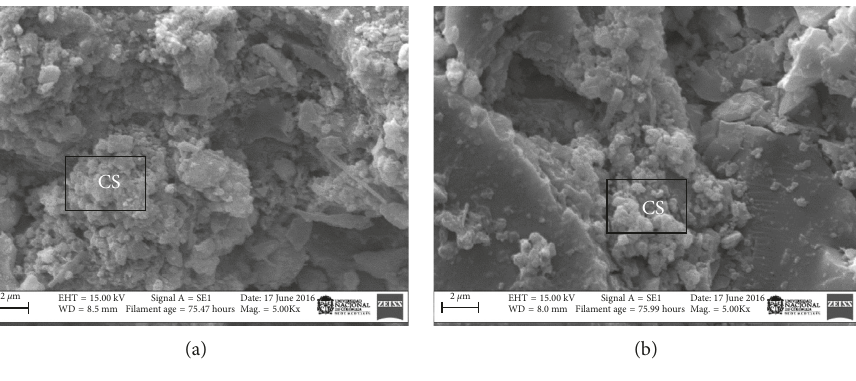
Figure 9: ITZ of (a) ALC5S-0 and (b) AlC5S-10.